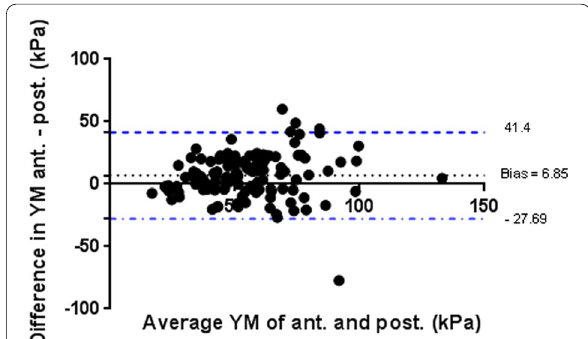
Fig. 3 Bland–Altman plot of the difference in mean YM measurements between the anterior and posterior CCA wall of each participant